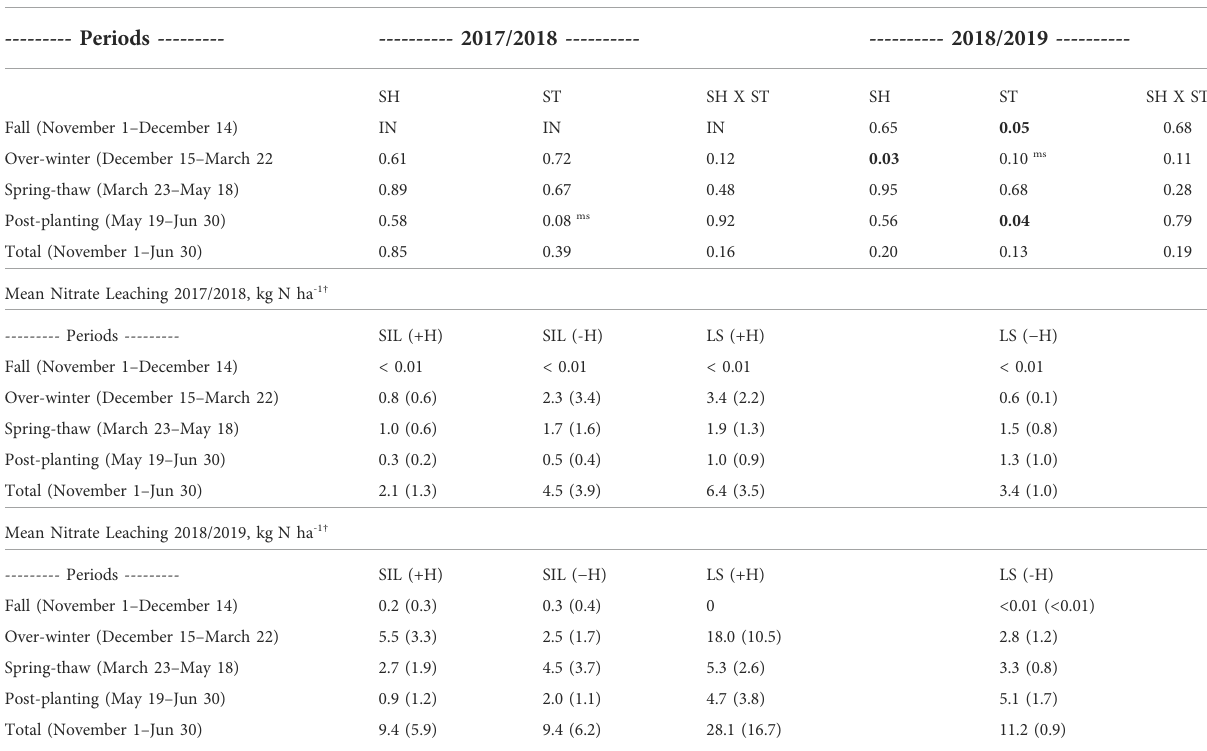
TABLE 3 p -values of the two-way ANOVA used to test main effects (SH, soilheating; ST, soil type) and the interaction SH × ST on the nitrate leaching, forperiodsofthe2017/2018and2018/2019seasons,andrespectiveaverages(standarddeviationisshowninparenthesis).Boldedvaluesindicate p ≤